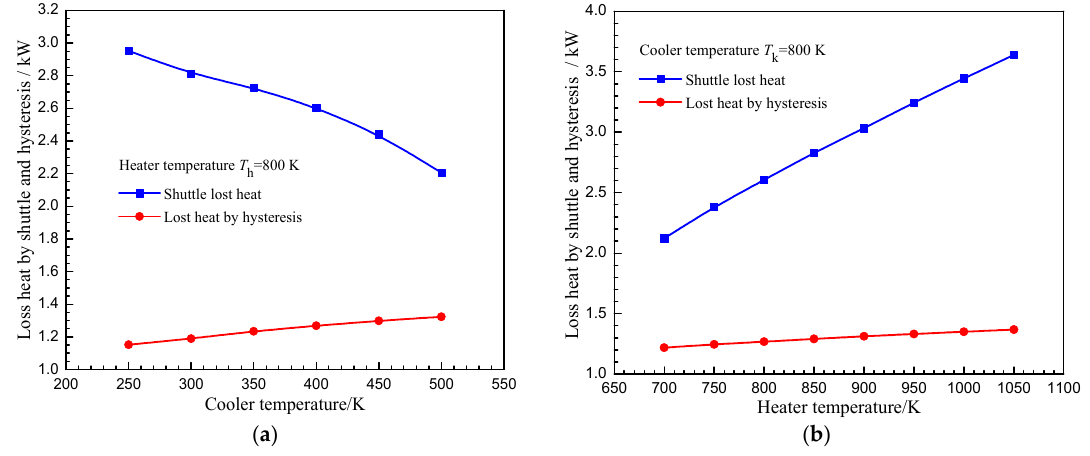
Figure 15. The effect on heat loss due to shuttle and hysteresis: ( a ) effect of cooler temperature, ( b ) effect of heater temperature.